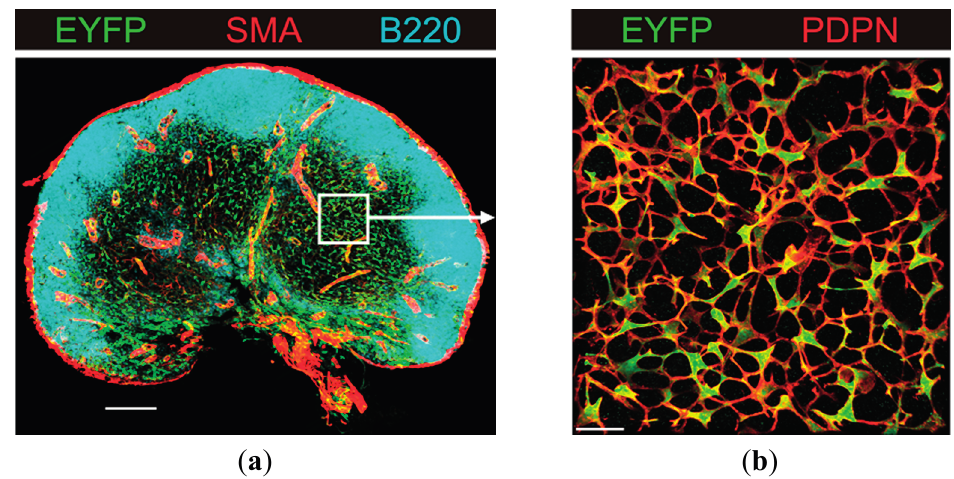
Figure 1. ( a ) Lymph node (LN) architecture with major structural units: subcapsular sinus (red), efferent lymphatic vessel (red), B cell follicles (cyan) and the FRC network (green). White rectangle indicates representative T cell zone; ( b ) High resolution Z-stack of the topology of the T cell zone fibroblastic reticular cell (FRC) network. Podoplanin (PDPN) is also used as a marker for FRCs. Scale bars represent 200 and 30 μ m, with Z-depth 38.6 and 23.6 μ m, respectively.